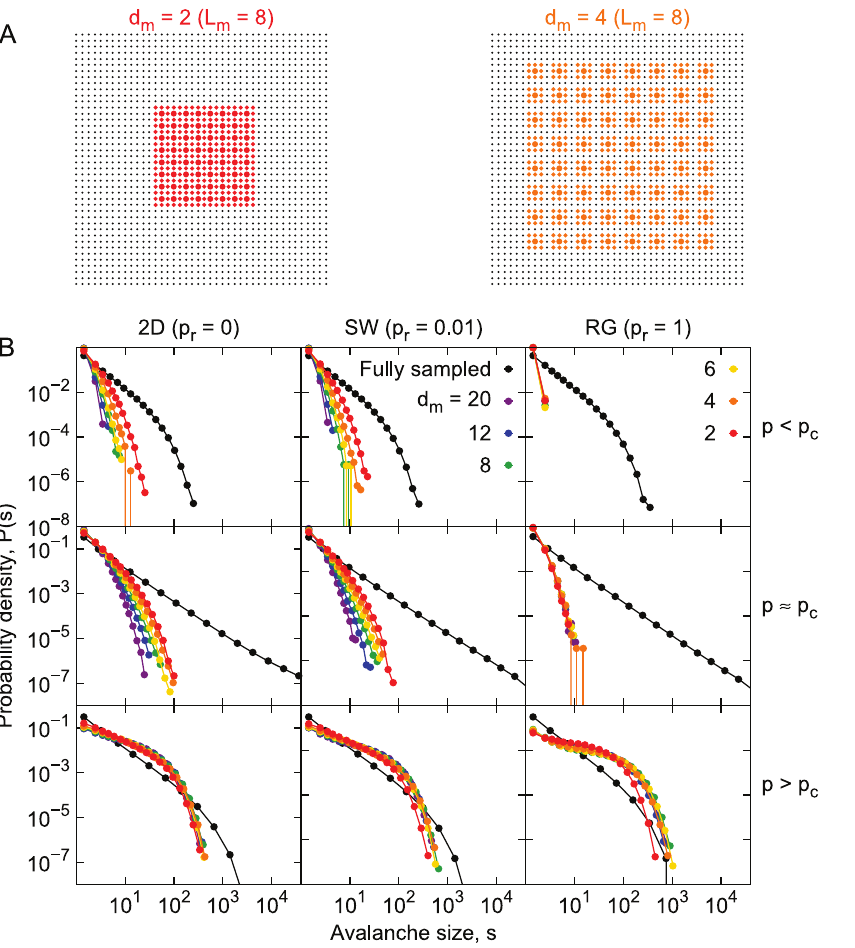
Figure 5. Undersampled size distributions: varying the density of sampled sites. A) Examples of the sampling matrix. Only the colored sites are considered for avalanche measuring. Colored circles indicate virtual electrodes center, with diamond indicating possible sampling sites (see Methods). B) Avalanche size distributions obtained from different underlying topologies (columns) and dynamical regimes (rows), while sampling the systems with a MEA-like configuration. Colors represent different spacing between electrodes of the virtual sampling MEA (black for fully sampled systems).